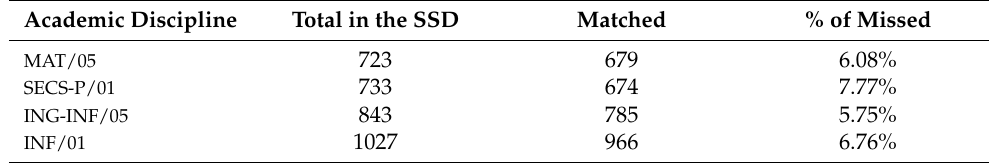
Table 1. The results of searching and